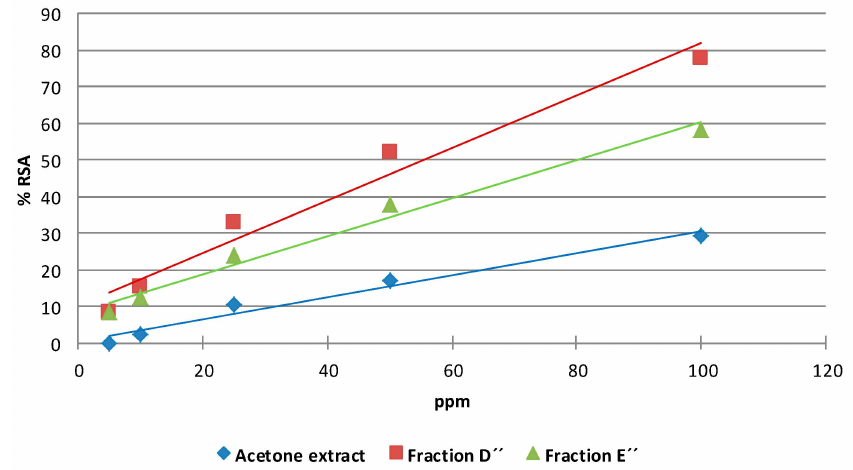
Figure 8. DPPH radical scavenging activity of the acetone extract and its fractions from citrus by-products. Fraction D 11 showed the highest scavenging activity. Fraction E 11 showed medium activity antioxidant. The acetone extract showed the lowest scavenging